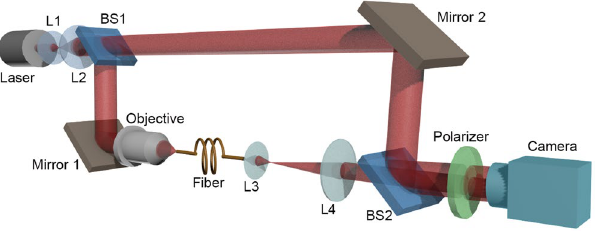
Figure 1. Experimental setup for MD experiments, BS1 and BS2 are beam splitters, L1, L2, L3 and L4 are